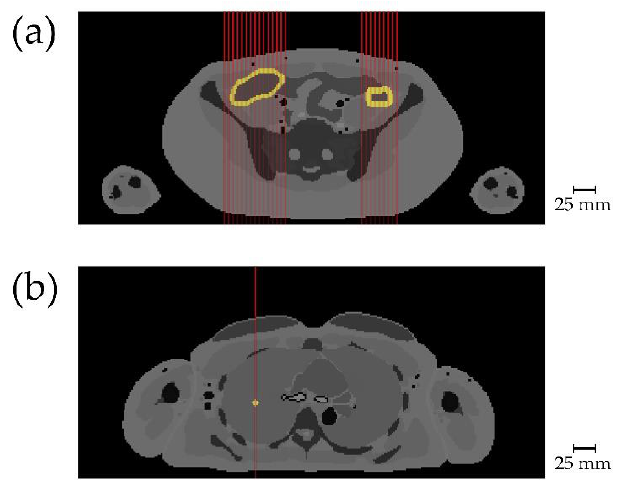
Figure 3. Scanning positions with target locations. Target tissue with added gold is shown in light yellow, red lines indicate incident X-ray beams. ( a ) Slice 203 of voxel phantom, entire colon, hence both right and left colon contained gold for scan. Only incident beams for scan from front are shown; ( b ) slice 277 of voxel phantom with target 4 in right lung. Incident beam shows that here only a single point is scanned. Scale bar in mm, note that one voxel is 1.78 × 1.78 mm wide in this view.